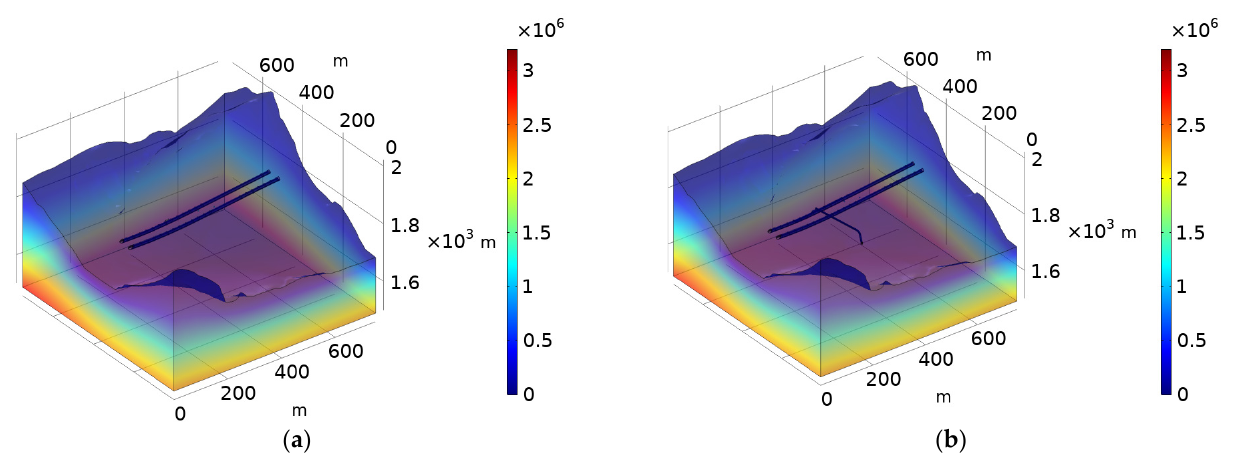
Figure 13. Positions of each section in the 3D calculation model of working condition 3.